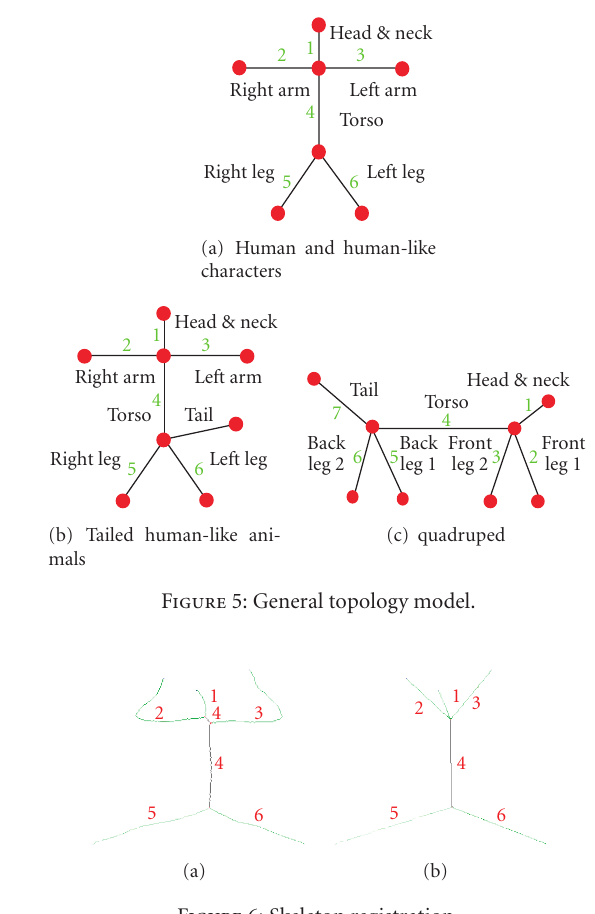
Figure 6: Skeleton